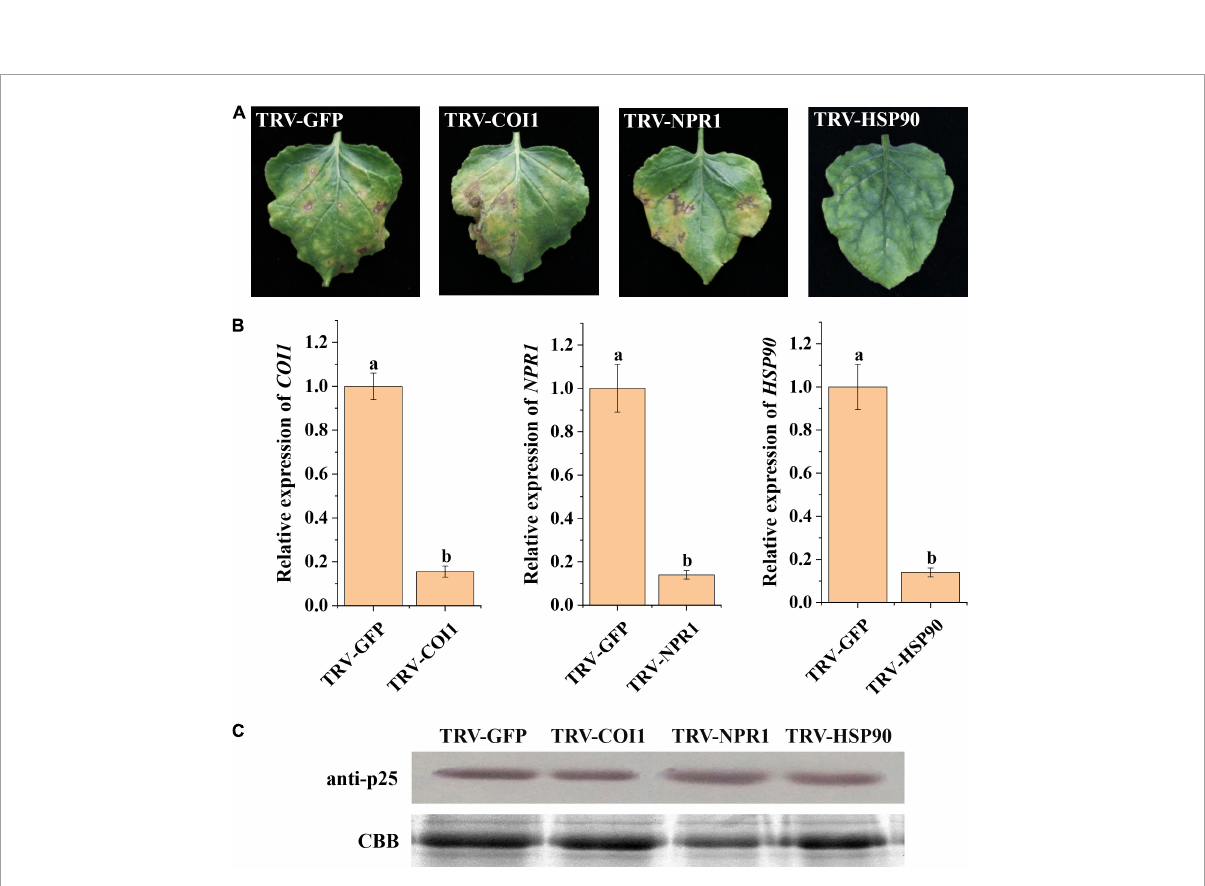
FIGURE6 Analysis of plant resistance genes involved in TMV-p25 infection. (A) Leaves were infiltrated with Agrobacterium -containing pTRV1 or pTRV2-NbNPR1/NbCOI1/NbHSP90 plasmids. pTRV2-GFP was used as a control, and then plants were inoculated with hybrid virus TMV-p25. (B) RT-qPCR analysis of Nicotiana benthamiana leaves after VIGS. Error bars represent standard deviations. Different letters above the bars for each treatment indicate a significant difference (Student’s t -test, p < 0.05). (C) Western blot of p25 protein using the anti-p25 antibody. The Rubisco protein was stained with Coomassie brilliant blue (blue bands) as a total protein loading